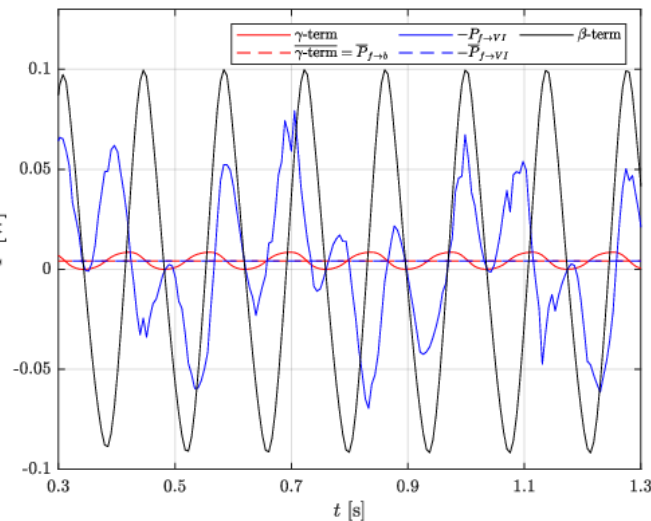
Figure 7. Comparison among power terms. γ and β − terms refer to the instantaneous power linked to the RHS of Equation (14); mean value γ − term is the power transfer in Equation